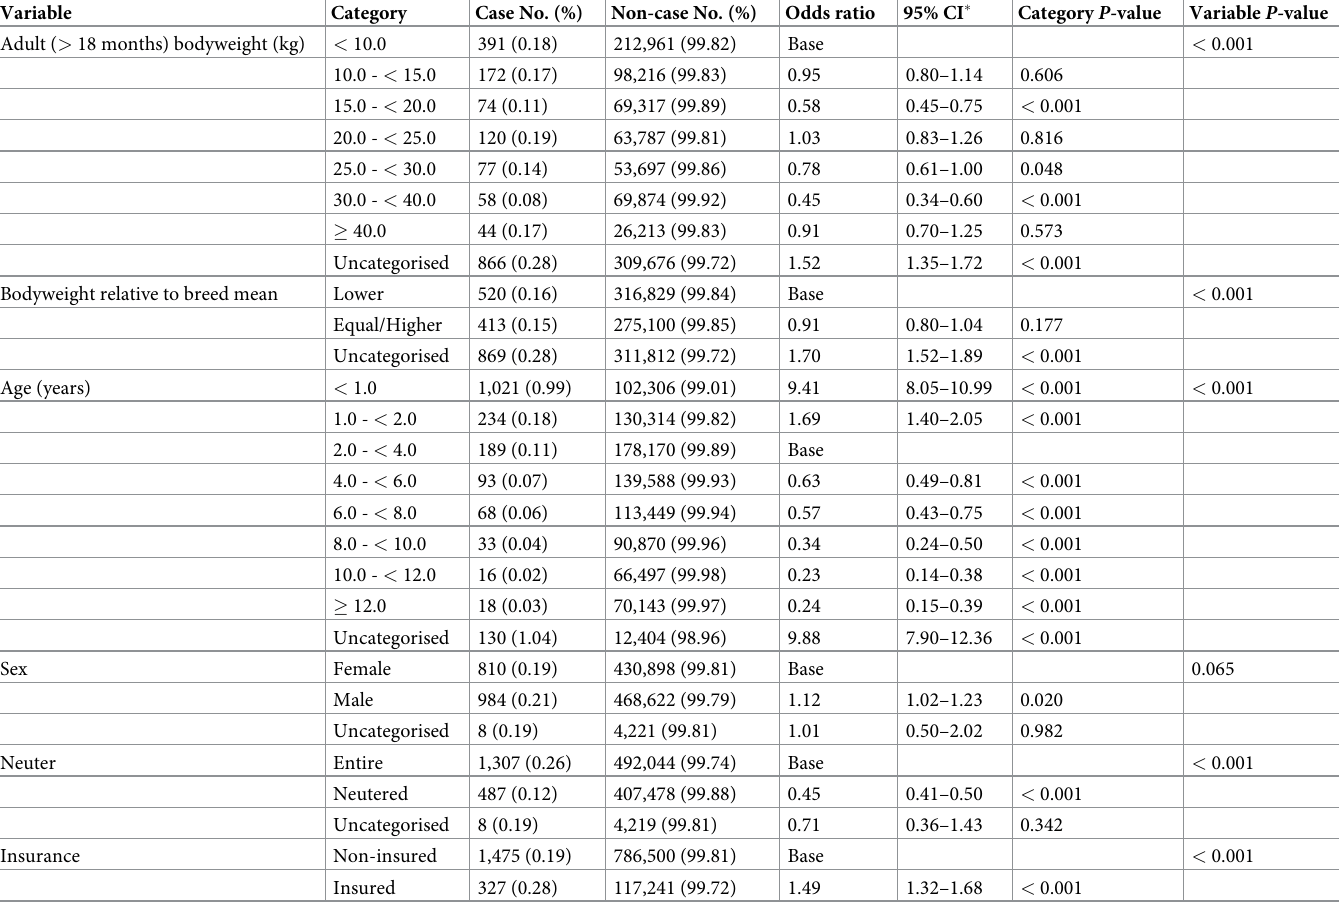
Table 3. Descriptive and univariable logistic regression results for non-breed-related demographic risk factors evaluated for prolapsed nictitating membrane gland (PNMG) during 2016 in dogs under primary veterinary care in the VetCompass ™ Programme in the UK. Column percentages shown in brackets. Variable